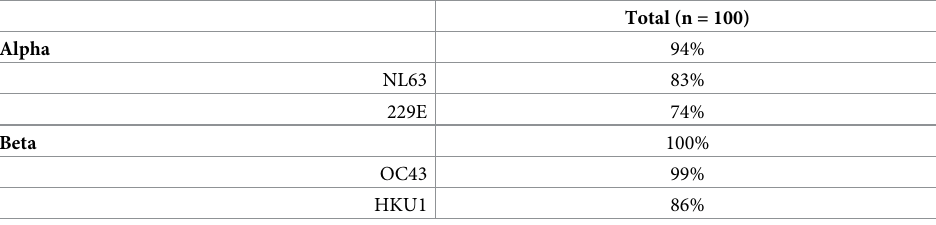
Table 1. Endemic HCoVs ELISA results, %